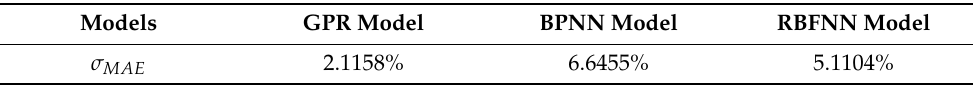
Table 6. Quantitative results predicted by GPR model, BPNN and RBFNN